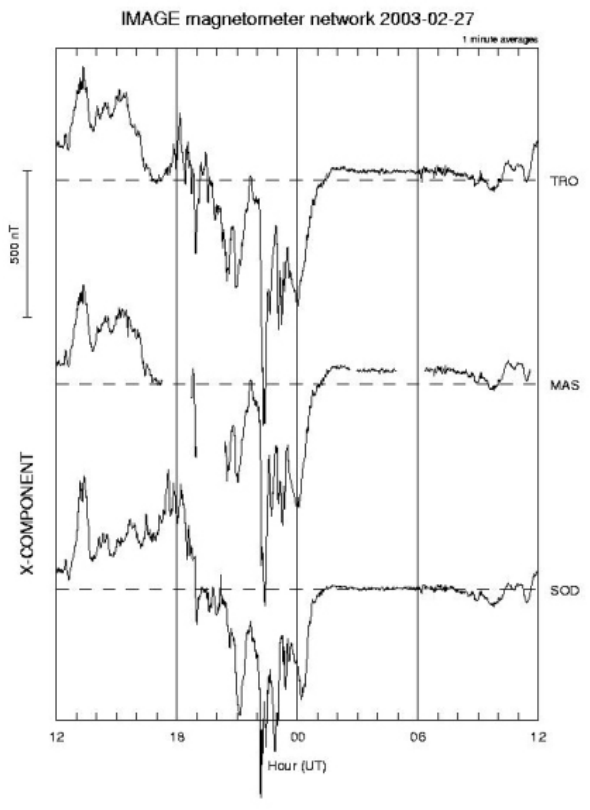
Fig. 4. IMAGE magnetometer traces from Tromsø, Masi and So- dankyl¨a showing the B x component on the night of 27–28 February 2003 for a latitude range of 67 ◦ –70 ◦